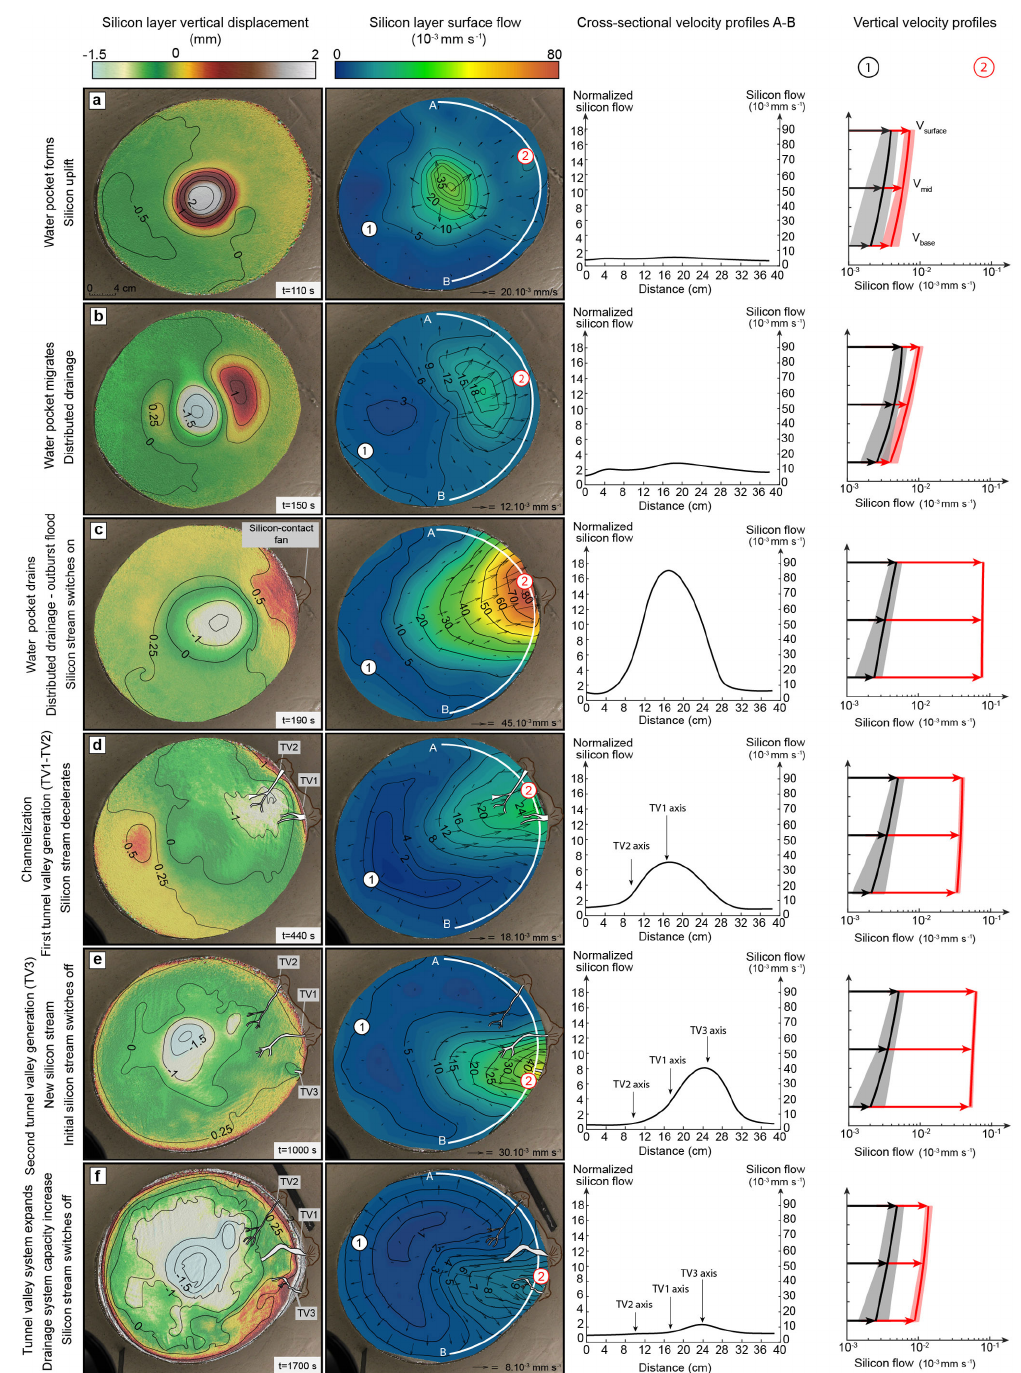
Figure 3. Temporal evolution of the experiment. (a) Formation of water pocket, uplift of silicon surface uplift, and acceleration. (b) Migration of water pocket and overlying region of uplift and accelerated flow. (c) Marginal drainage of water pocket and onset of silicon streaming. (d) Tunnel valley development and silicon stream deceleration. (e) Formation, migration, and marginal drainage of a new water pocket and development of a second silicon stream and of a new tunnel valley. (f) Decay of the second silicon stream. From left to right: (i) maps of vertical displacements of silicon layer surface, (ii) maps of horizontal velocity at silicon layer surface, (iii) cross-sectional velocity profiles (absolute velocity on the right axis; velocity normalized by background velocity on the left axis; profile locations indicated by white lines A–B on maps), (iv) vertical velocity profiles for the silicon stream (red profiles, locations labelled 2 on maps) and for the region opposed to the silicon stream (black profiles, locations labelled 1 on